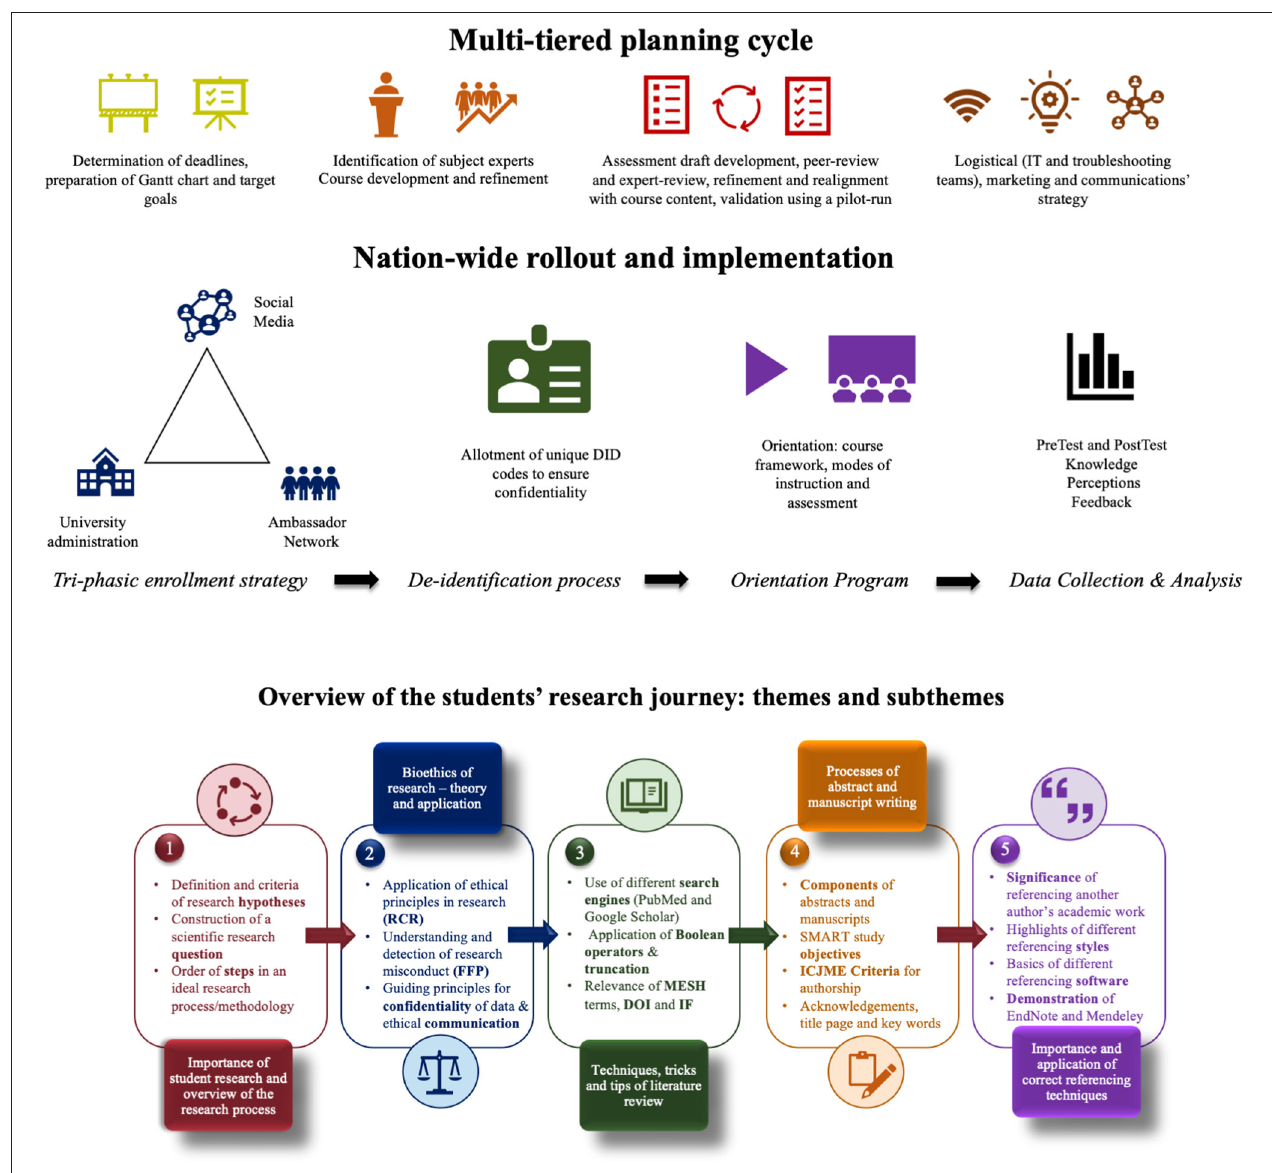
FIGURE 1 | Snapshot of the multifaceted design, implementation process and an overview of the students’ research